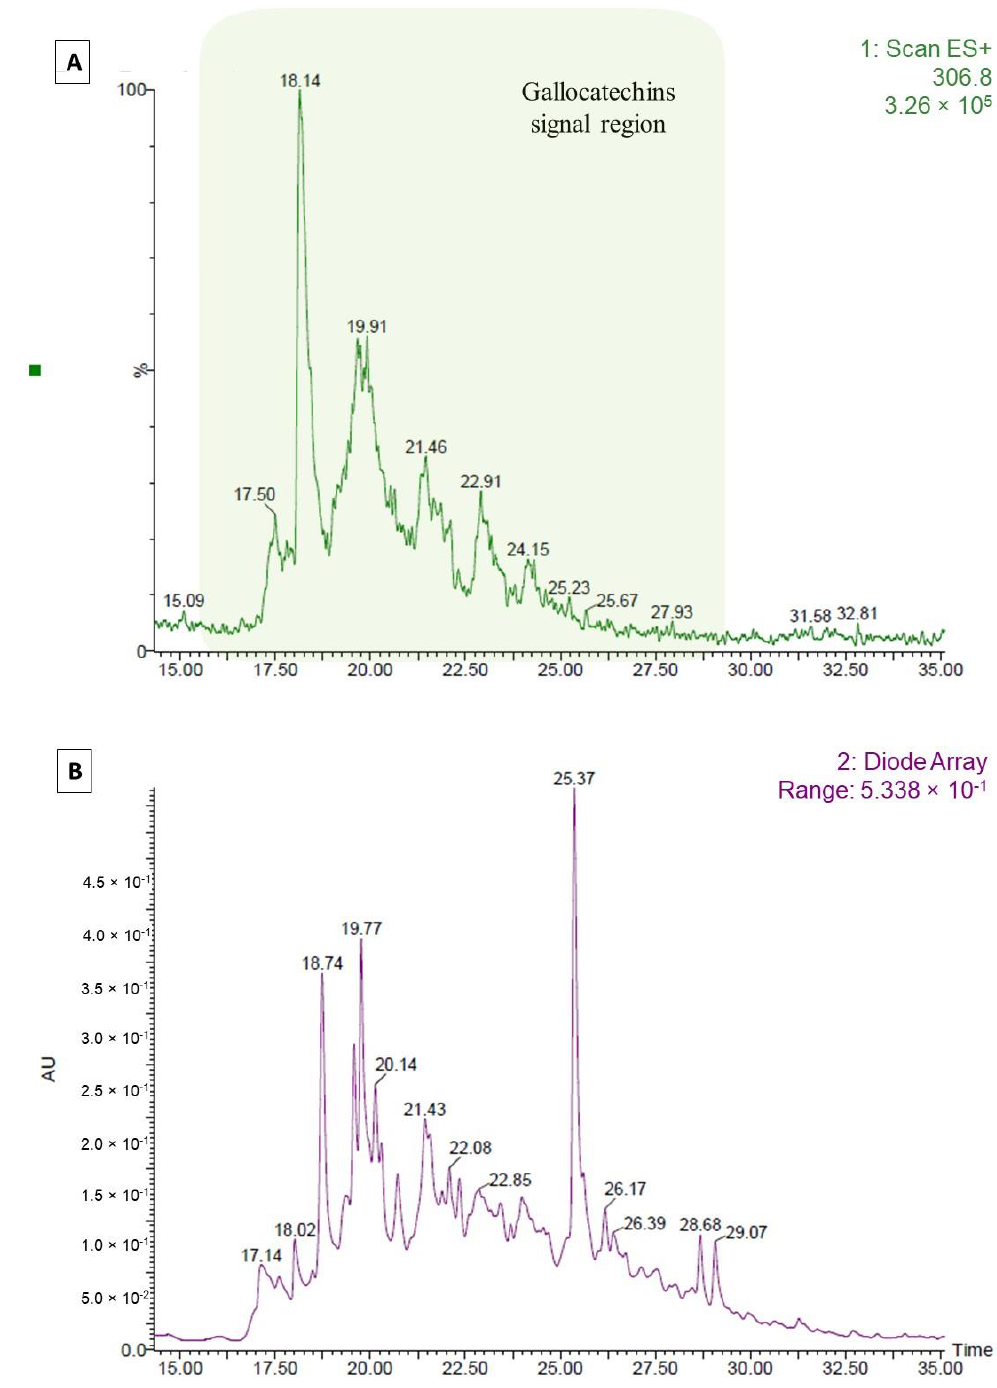
Figure 11. LC-MS analysis, detail for gallocatechins signal region (m/z: 306). ( A ) Mass spectra; ( B ) DAD chromatogram. Masses are selected +0.5 m/z due to detector calibration.